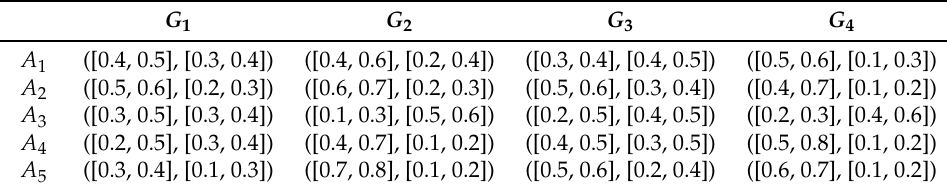
Table 1. Assessment of